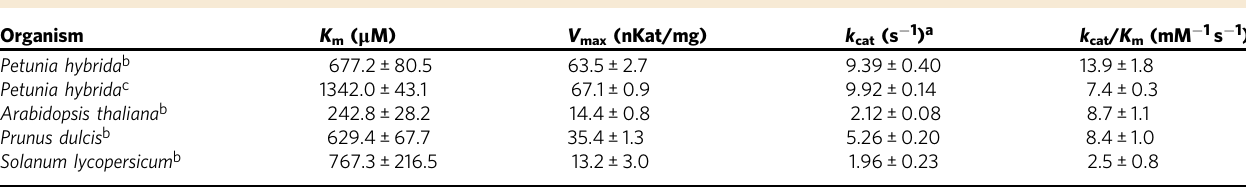
Data are means±error. Error values are standard errors as derived from nonlinear fi t analyses. n = 3 technical replicates. a Assuming one catalytic center per heterodimer of BS. b K m data were for benzoyl-CoA, measured at 4mM NADPH. c K m data were for NADPH, measured at 3.6mM benzoyl-CoA. marker protein. The N-terminal fusion proteins, GFP-PhBS α and GFP-PhBS β , showed peroxisomal localization while the C-terminal fusion proteins, PhBS α -EYFP and PhBS β -EYFP, with blocked peroxisomal targeting signals failed to enter peroxisomes